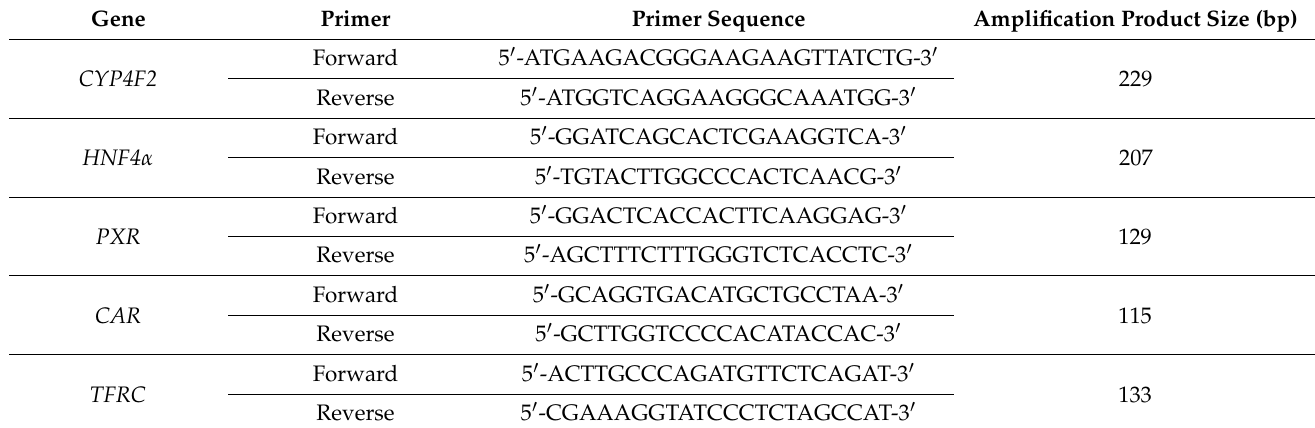
Table 1. qPCR primers used for gene expression evaluation.